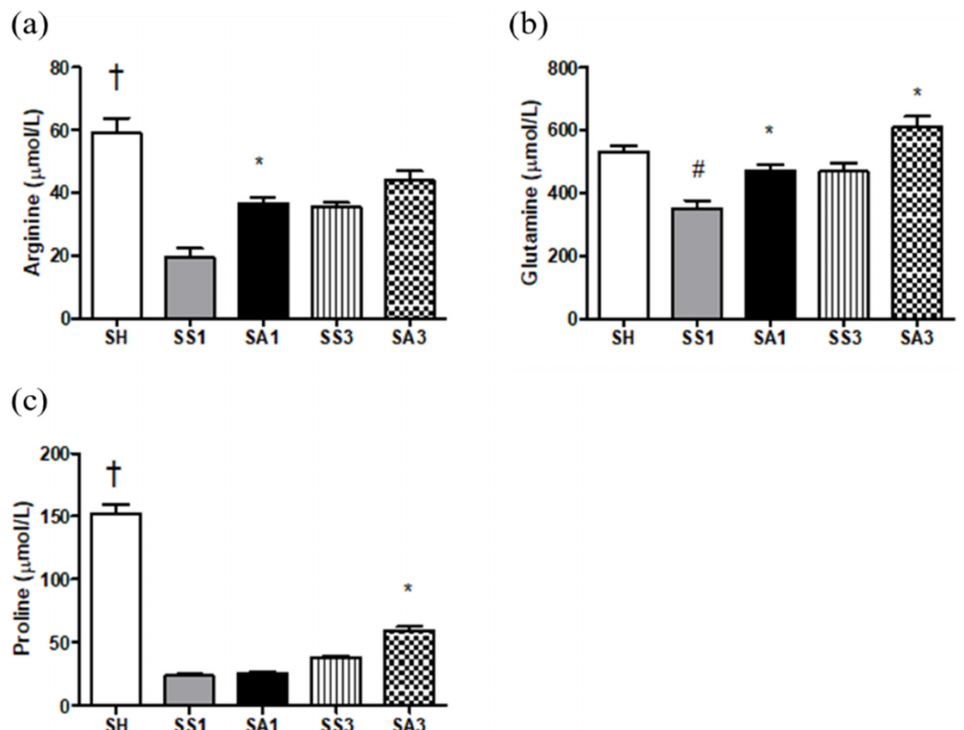
Figure 2. Plasma amino acid concentrations among the experimental groups. ( a ) Arginine, ( b ) glu- tamine, and ( c ) proline. Data are presented as the mean ± SEM. SH, sham group without a sleeve gastrectomy (SG); SS1 and SS3, saline groups sacrificed on day 1 or 3 after the SG; SA1 and SA3, arginine groups sacrificed on day 1 or 3 after the SG. A two-way analysis of variance (ANOVA) with the Bonferroni post-hoc test was used to analyze differences among the SH and gastrectomy groups. † Significantly differs from the gastrectomy groups. # Significantly differs from the SH group. * Significantly differs from the SS group at the same time point ( p <